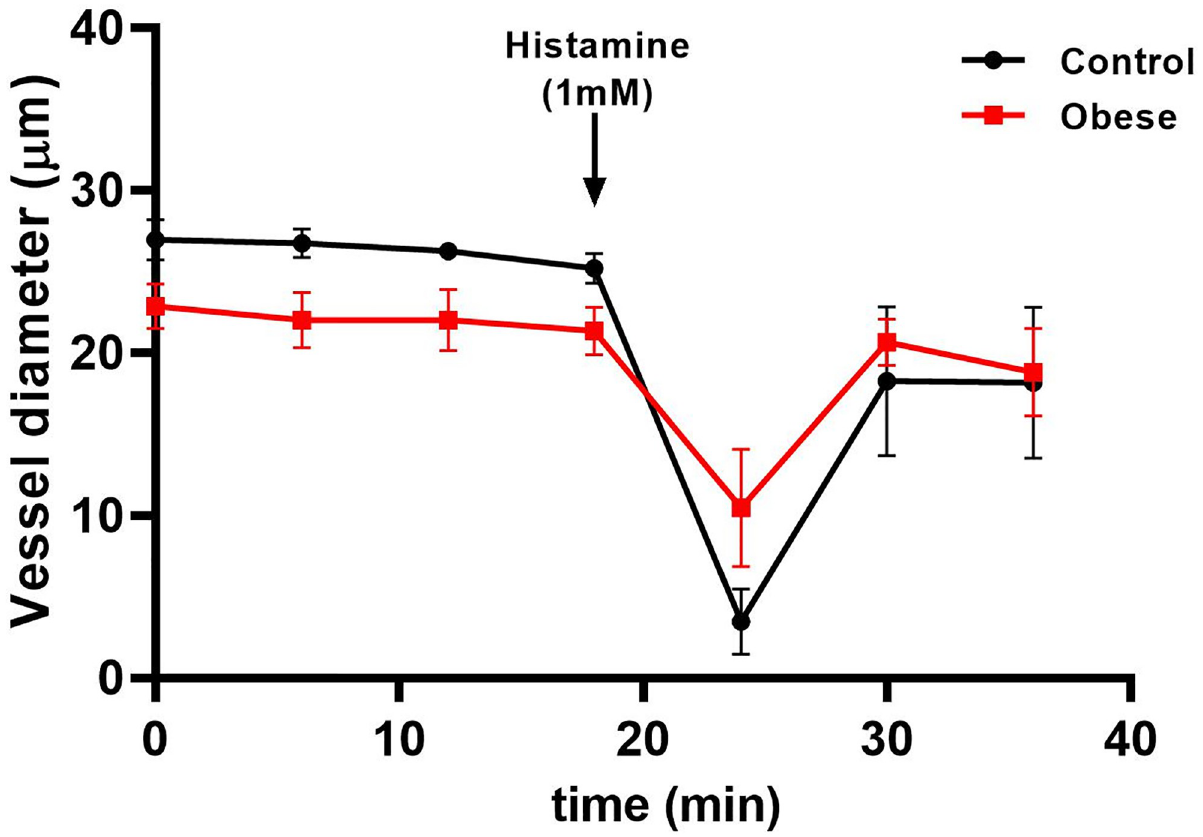
Fig 10. Time- course of histamine effect on vessel diameter. Microvessels diameter of SD and HFD mice cremaster muscle was evaluated during 35 min. A vasoconstrictor effect was observed after histamine (1 mM) stimulation (arrow) followed by vasodilation after histamine suspension. Data represent the mean ± standard error of four different experiments. � p � 0.05 vs